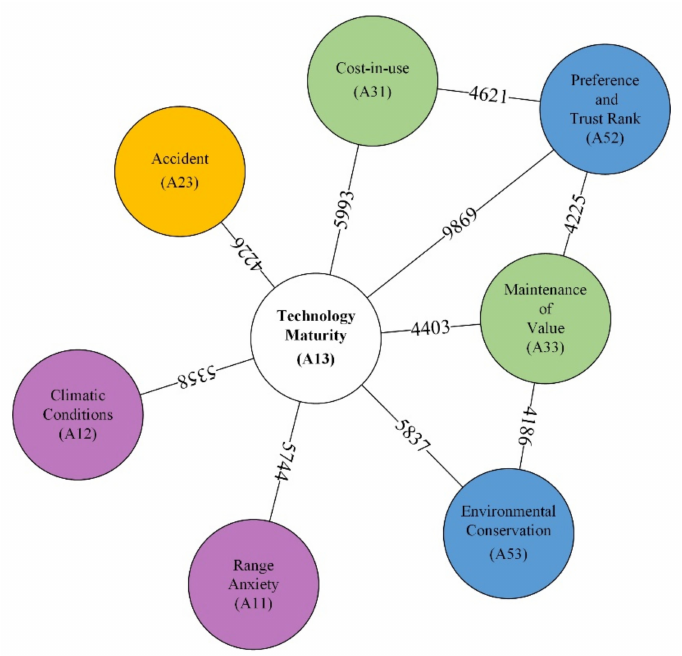
Figure 8. Co-occurrence Network